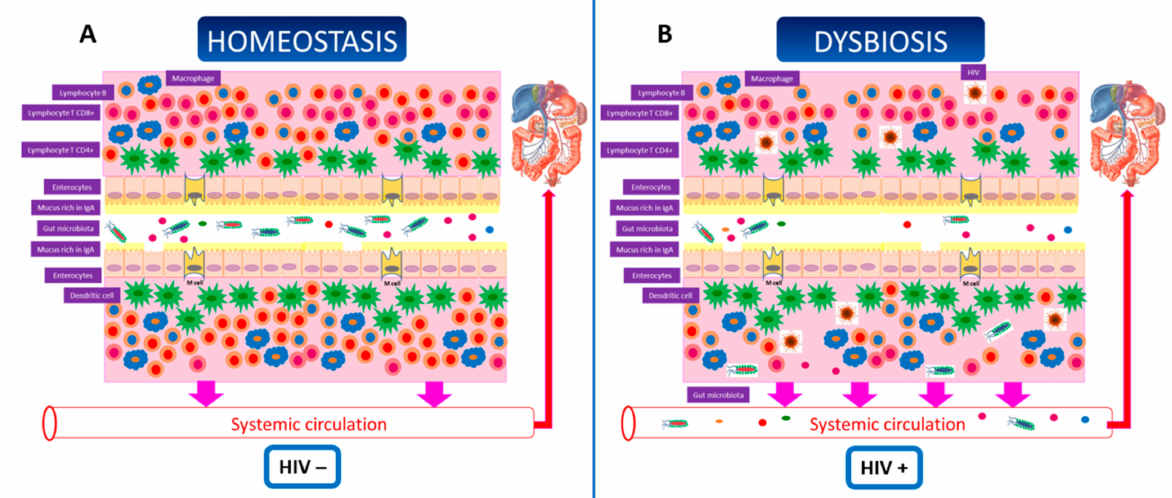
Figure 1. Under normal physiological conditions, microorganisms in the intestinal lumen interact with intestinal cells in a state of symbiosis; however, when HIV infection occurs, depletion of CD4 + T lymphocytes occurs in the gut-associated lymphoid tissue. This is accompanied by rupturing of the epithelial barrier, which triggers alterations in the intestinal lumen as well as the composition of the microbiota (at least at the bacterial level) [18]. This dysbiosis favors the passage of microorganisms and their components to the lamina propria and, therefore, to the circulation, which is known as bacterial translocation (BT), leading to subsequent intestinal and systemic inflammation [19]. ( A ) Gut homeostasis. ( B ) Gut dysbiosis after HIV infection. Modified from P é rez-Matute P et al.